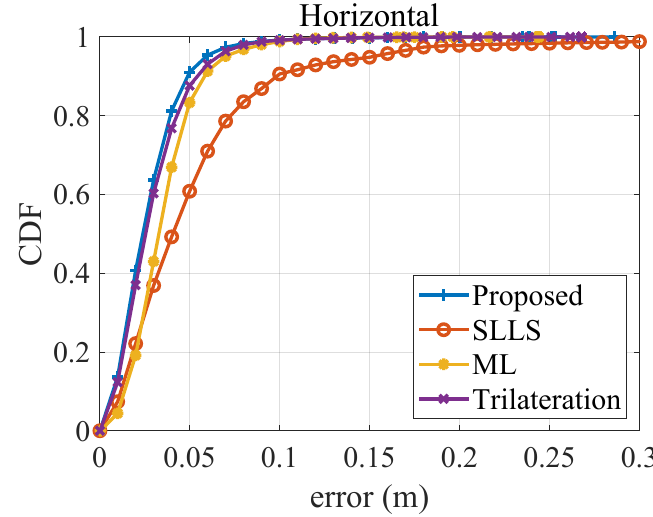
Figure 7. The CDF of horizontal positioning error.